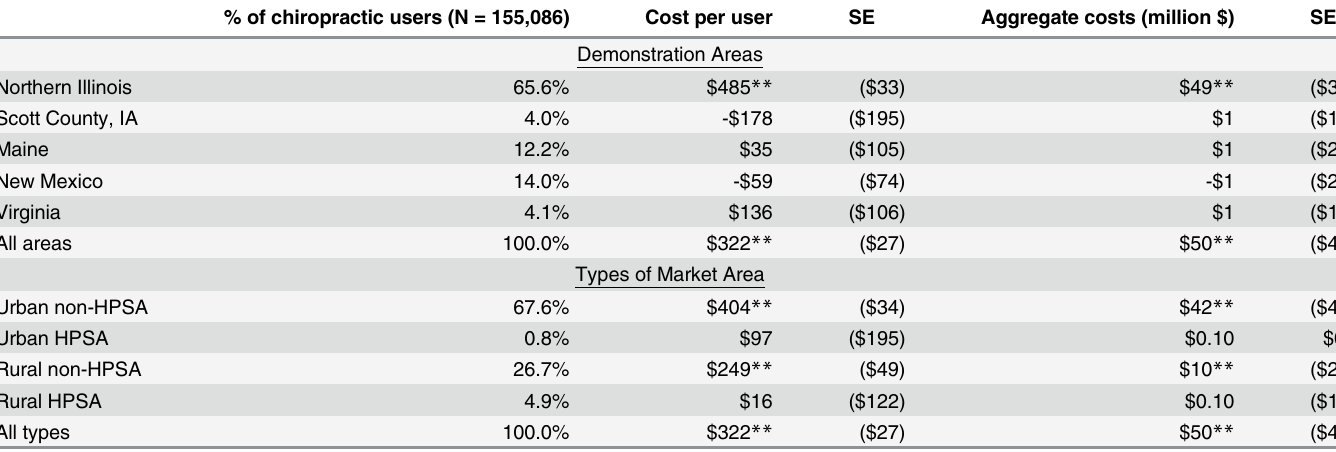
Table 4. Changes in Medicare Costs in Chiropractic Users by Demonstration Area and Type of Market Area. % of chiropractic users (N =